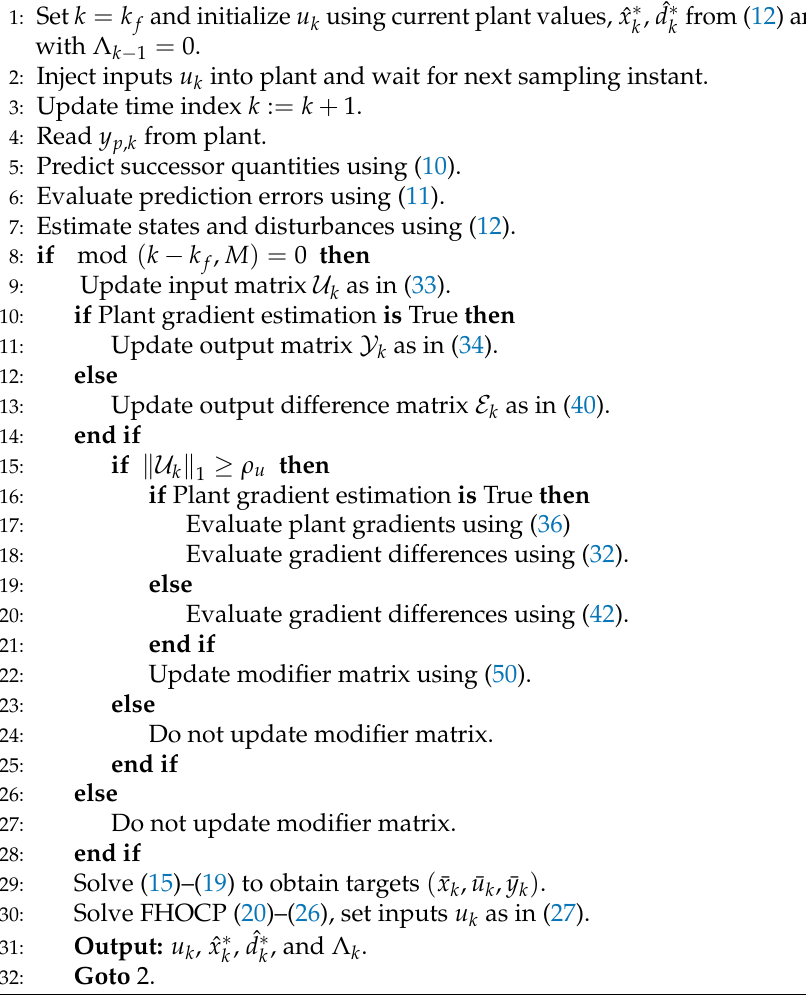
Algorithm 2 Offset-free eMPC algorithm using linear